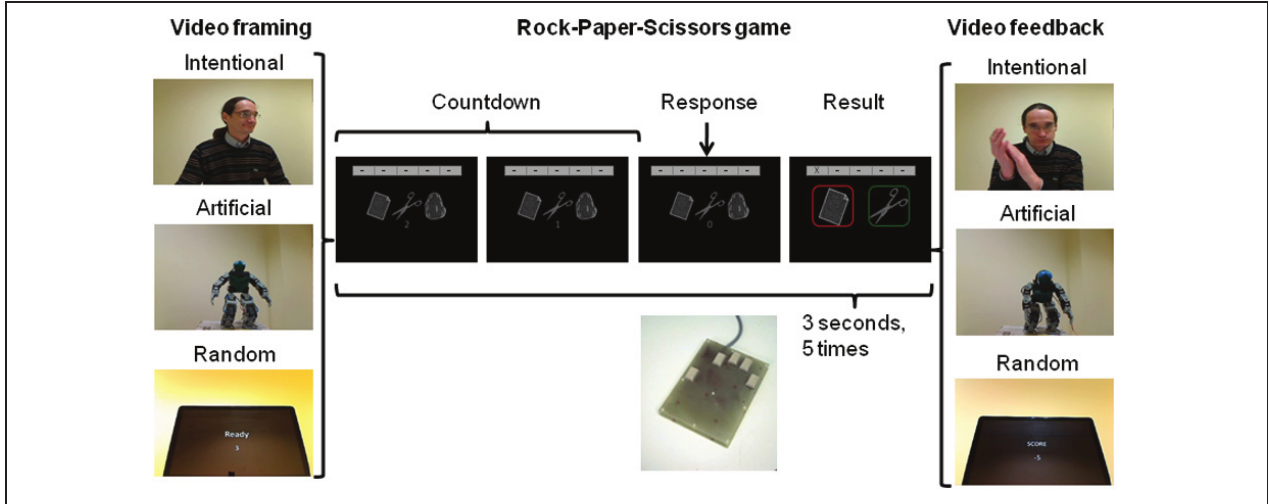
FIGURE 1 | Experimental paradigm. Each game of Rock-Paper-Scissors consisted of a countdown, a response screen and a result screen, and lasted 3s. Five games were played for a round against one given opponent,